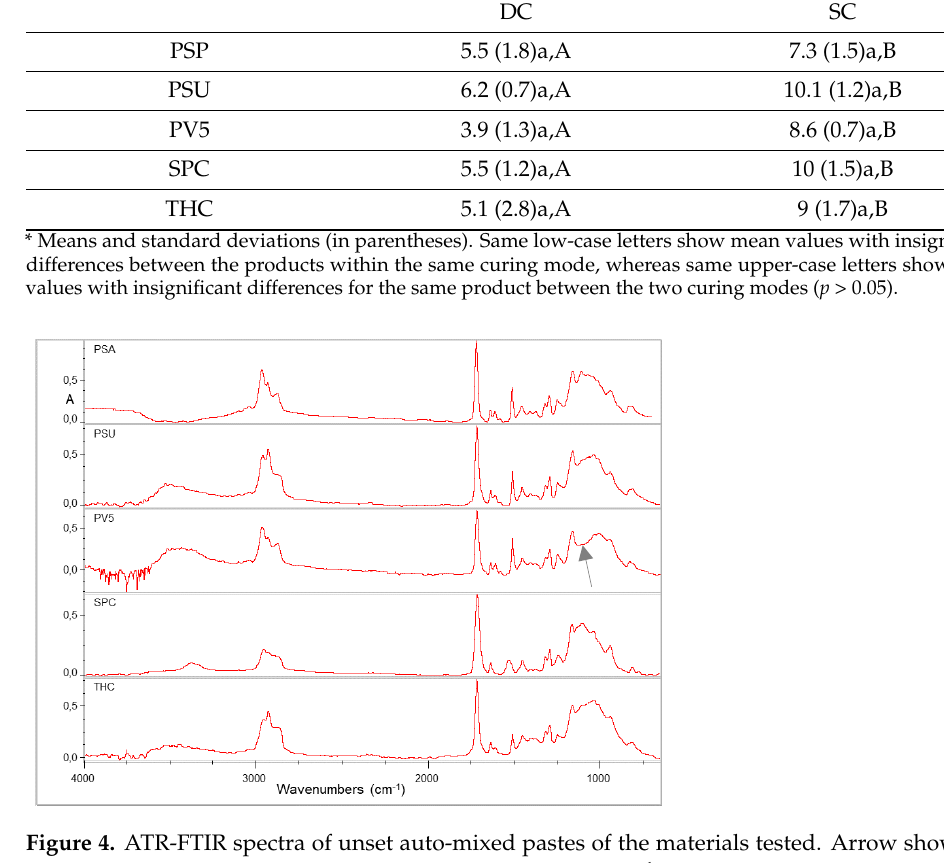
( b ) Figure 5. Expanded ATR-FTIR spectra of aromatic ( a ) and aromatic-free ( b ) materials before and after setting under the two curing modes, with the corresponding peak assignments used for DC% measurements ( y -axis:Absorbance units-A; x -axis: Wavenumbers-cm − 1 ).